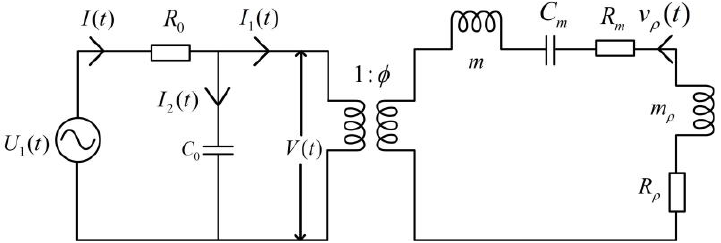
Figure 4. The acoustic-electric equivalent of each arc-slice of the tangentially polarized thin cylindrical transducer: U 1 ( t ) is the driving-voltage signal that excites the source transducer; V ( t ) is the voltage between two electrodes of each thin arc-slice in the transducer; v ρ ( t ) is the particle displacement velocity on the surface of the transducer; R 0 is the output resistance of the driving circuit.